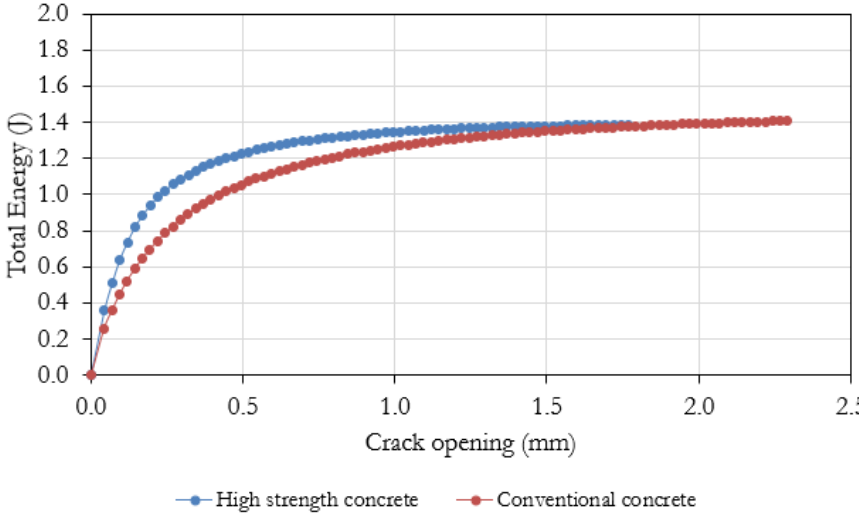
Figure 14. Overlap of the total energy curves along the concrete fracture tests.